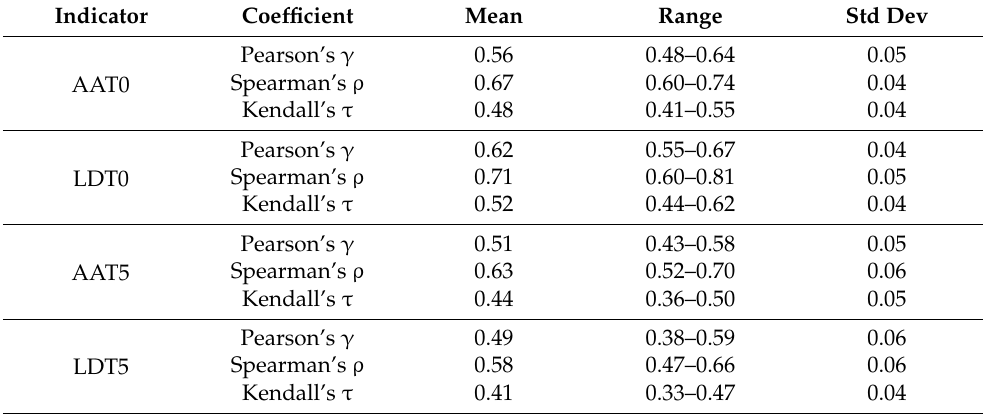
Figure 10. The Pearson correlation coefficient between the areal mean annual maximum NDVI and ≥0 (5) °C annual accumulated temperature and lasting days of the source region of the Yellow River during 2001–2016. Table 11. The mean value, range and standard deviation of annual linear correlation coefficient series between NDVI and indicators during 2001–2016 in the SRYR, checked by two-tailed test, α = 0.01. Indicator Coefficient